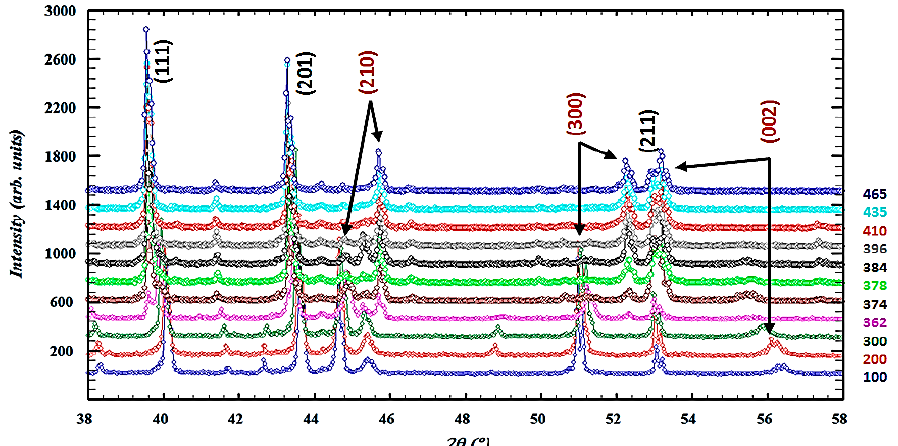
Figure 2. XRD patterns recorded on MnFeP 0.5 Si 0.5 for temperatures ranging between 100 and 465 K. For clarity, only half of the patterns are plotted. The first order magnetic phase transition occurs in the 274–284 K range. Extra small lines belong to the MnFe 2 Si impurities, as mentioned in Figure 1a and reported in Table 2.